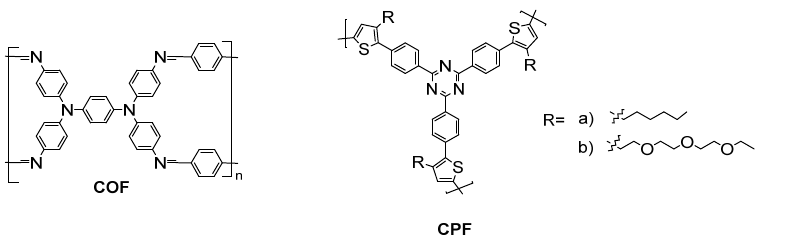
Figure 21. Representative electroactive covalent organic frameworks COF and CPF [192,194,196].